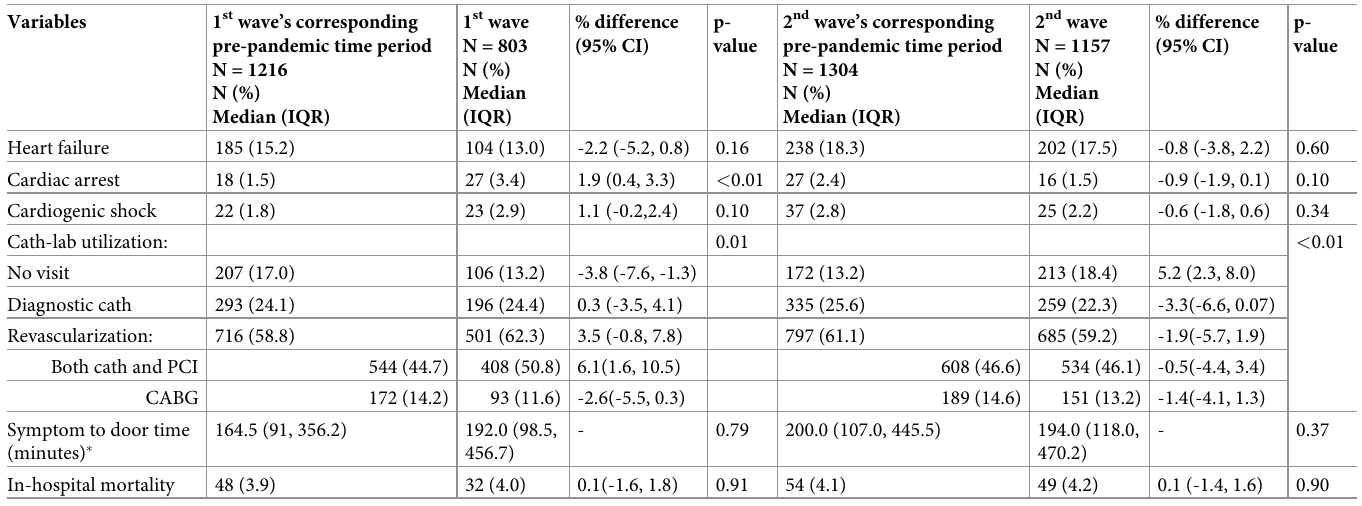
Table 3. Clinical presentation, management, and hospital outcome of ACS patients admitted during 1 st and 2 nd COVID waves and matched pre-pandemic months.